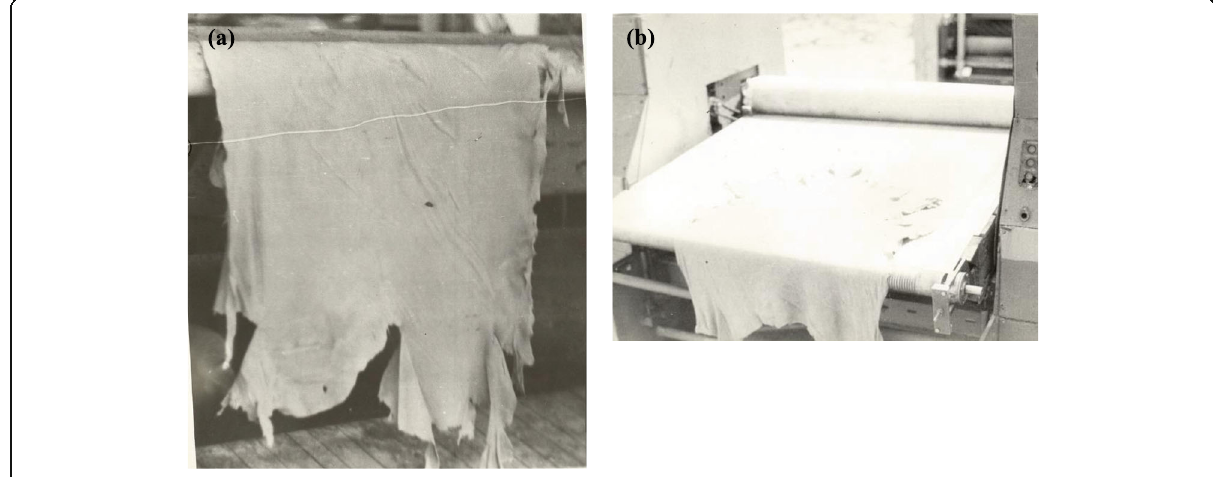
Fig. 2 Semi-finished leather product - chrome-tanned beef obtained from butt region ( a ), after pressing on roller squeezers ( b